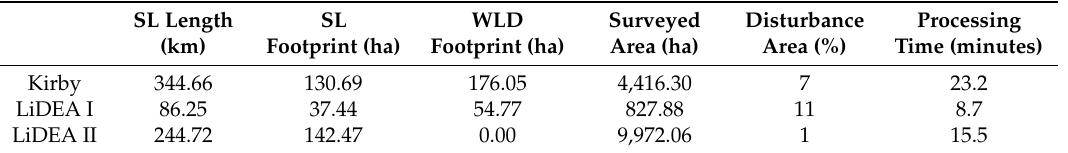
Figure 6. Mapped linear features (seismic lines and wide disturbances) using 25 cm pixel-size CHM inputs in the study areas Kirby, LiDEA II, and LiDEA I. The latter includes an inset map shown at larger scale with footprint polygons outlined in red overlaying an orthophoto background. Wide disturbances include roads, pipelines, and power lines. Table 2. Numeric results of mapping seismic lines (SL) and wide linear disturbances (WLD, i.e., roads, pipelines, power lines) using 25 cm pixel-size inputs. Processing time is given for the center-line step on seismic lines, which is the same order of magnitude as for the footprint step, obtained using Python